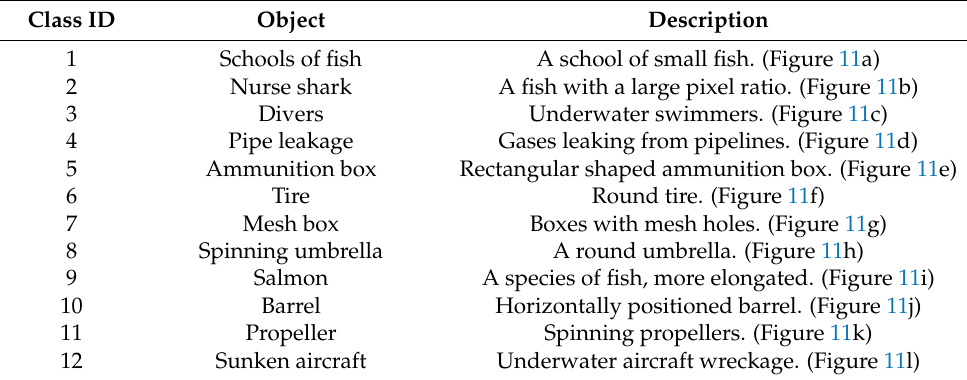
Table 6. Selection of semantic classes available in our dataset.